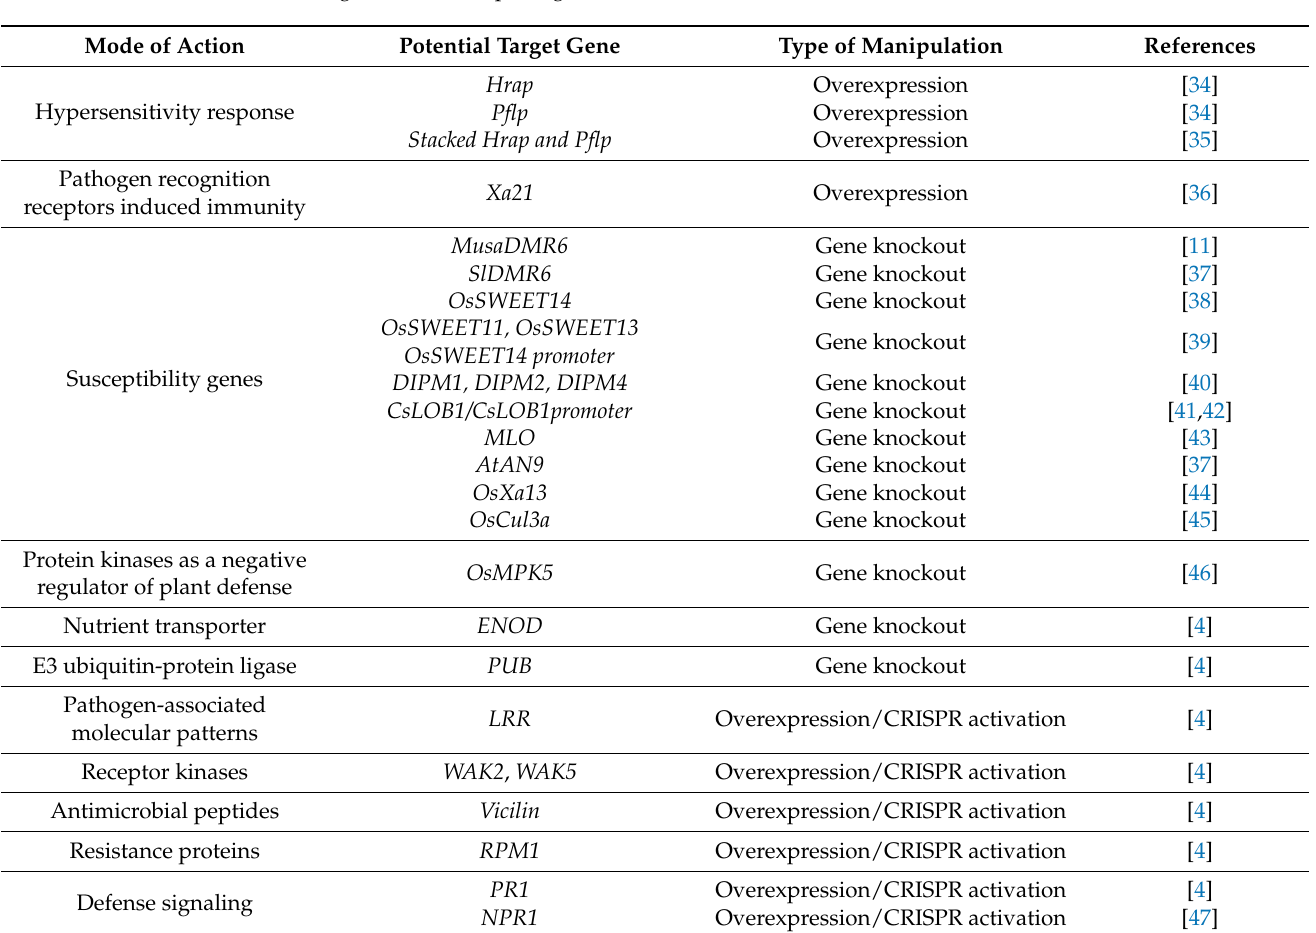
Table 1. Summary of potential target gene that could be manipulated in banana to develop resistance against bacterial